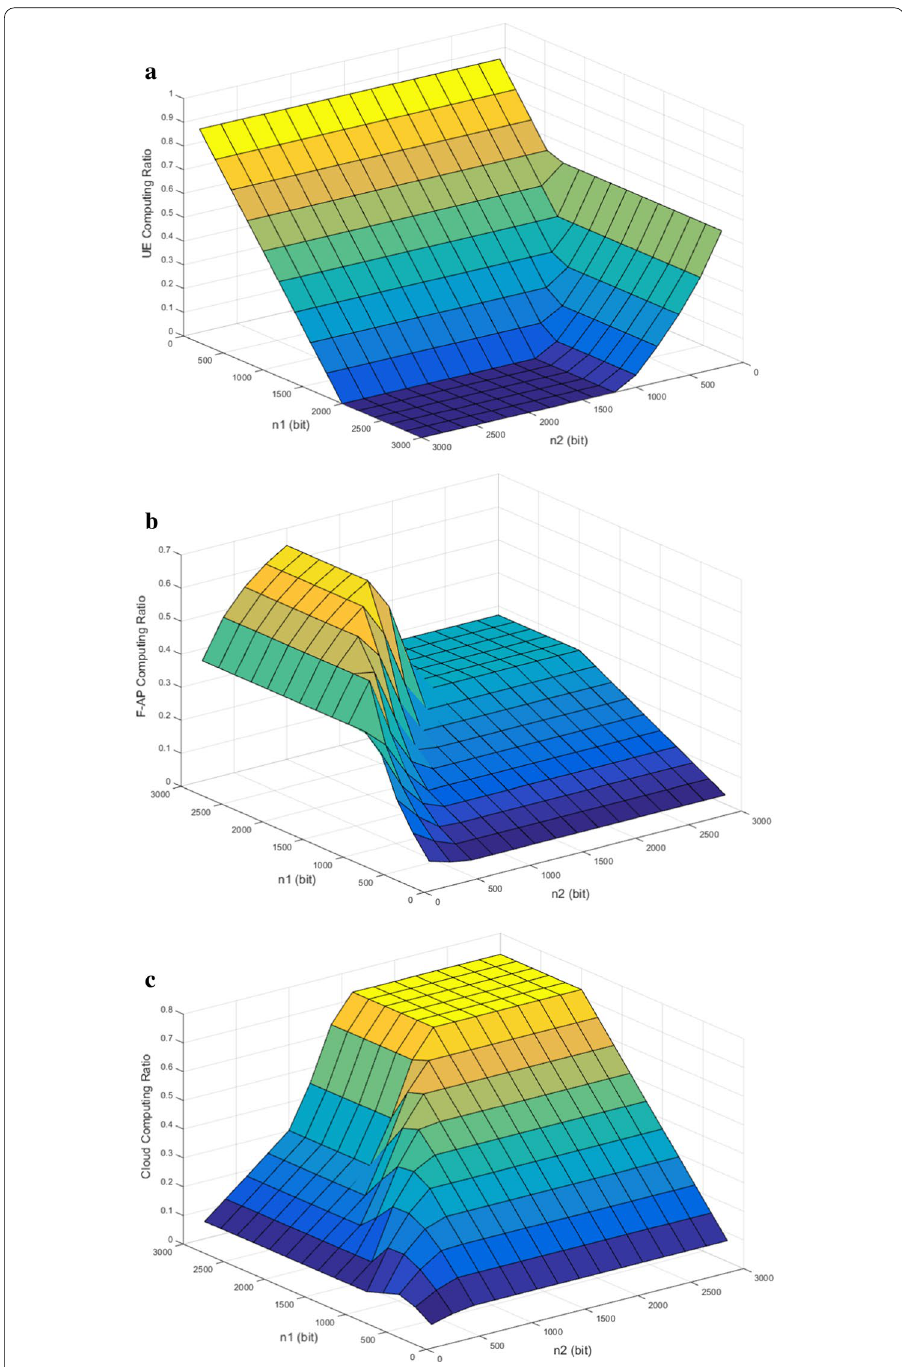
Fig. 6 Computing ratios with different value of receive capacity in mode 1. a UE computing ratio with different value of n 1 , n 2 in mode 1; b F-AP computing ratio with different value of n 1 , n 2 in mode 1; c Cloud computing ratio with different value of n 1 , n 2 in mode